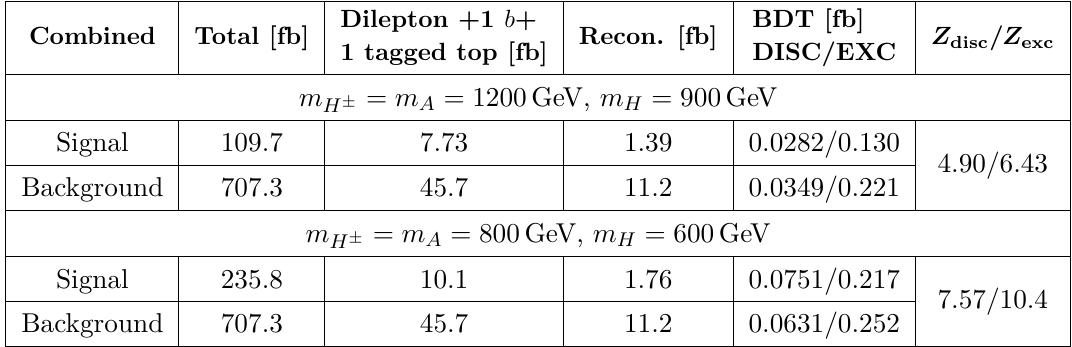
Table 4 . The combined signal and background cross sections with cuts at two benchmark points.